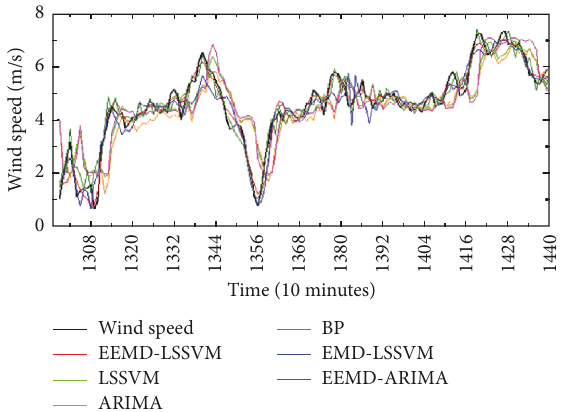
Figure 13: Three-step-ahead forecasting results (Case Two).